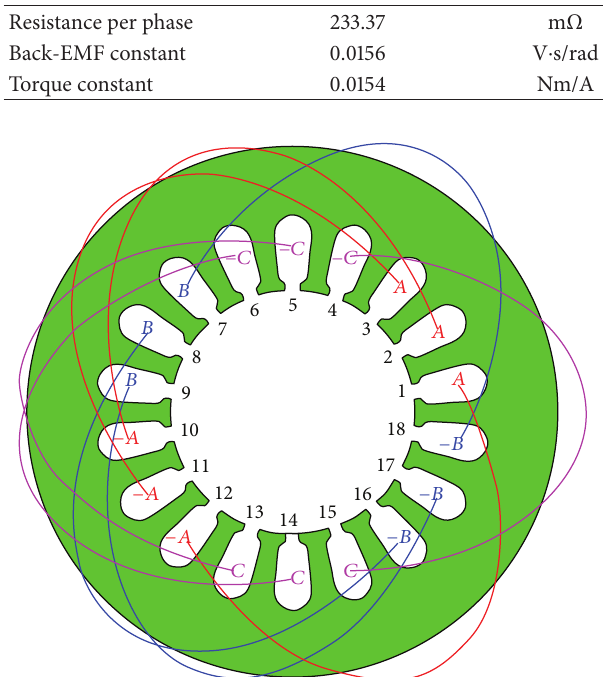
Figure 1: Motor winding scheme